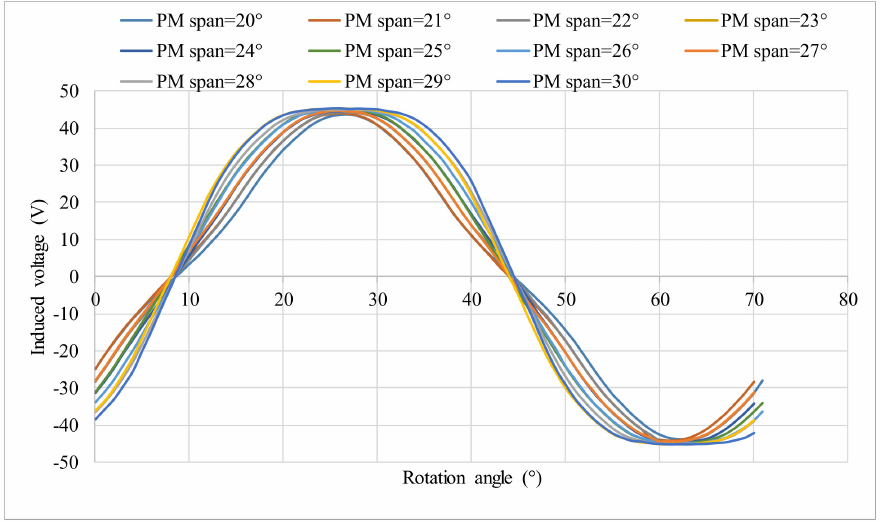
Figure 7. PM span influence on the induced voltage size of the